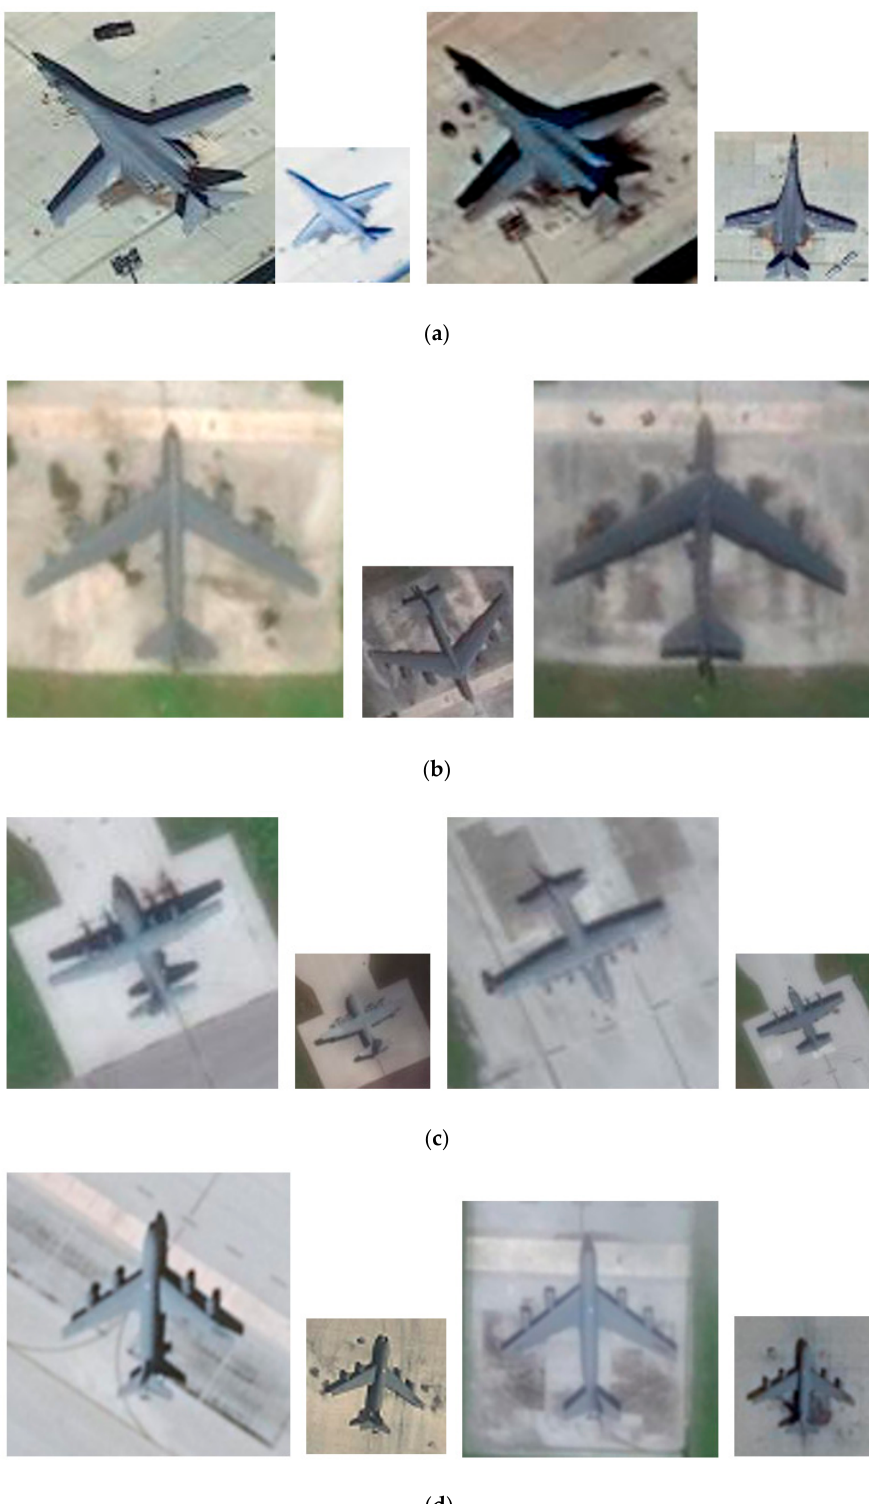
Figure 2. Representative samples from dataset 1. ( a ) Airplanes with type 1 from target domain and source domain. ( b ) Airplanes with type 2 from target domain and source domain. ( c ) Airplanes with type 3 from target domain and source domain. ( d ) Airplanes with type 4 from target domain and source